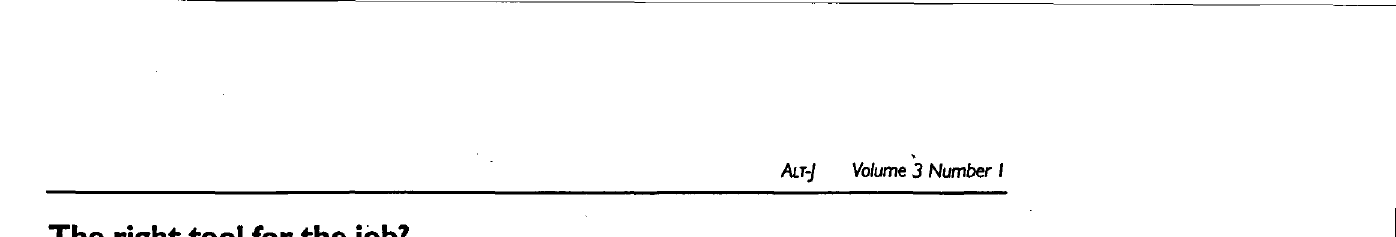
Table I: Table io show the relationship between computer-mediated learning and learning theory